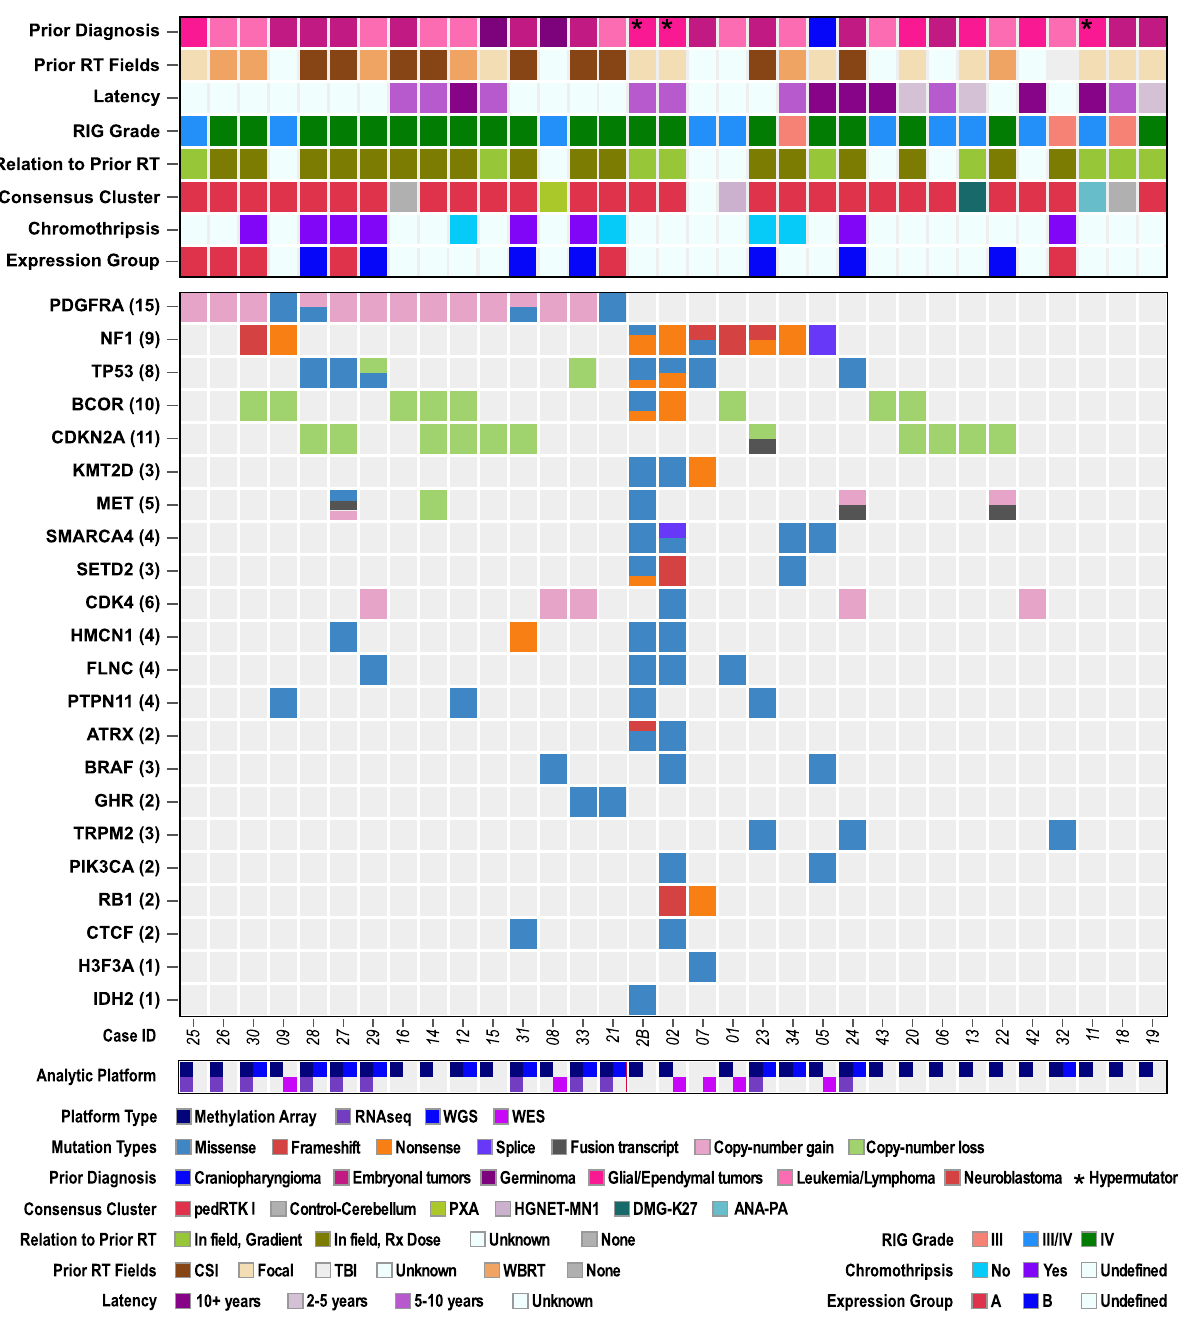
Fig. 4 Recurrent molecular alterations in RIG. Summary by RIG sample of clinical characteristics, histopathological features, methylation pro fi le, tier1 mutations, genes affected by copy-number gain/loss, and fusion genes. The second sample for Case 2 is shown as Case 2B, whereas the second samples for Case 14 and Case 12 are not shown but are annotated in Supplementary Data 1. ANA PA anaplastic pilocytic astrocytoma, CONTR-CEBM control cerebellum, DMG-K27 diffuse midline glioma H3.3 K27M, GBM-MID glioblastoma IDH-wild type, subclass midline, HGNET-MN1 high-grade neuroepithelial tumor with MN1 alteration, PXA pleomorphic xanthoastrocytoma, RIG radiation-induced high-grade glioma. Sequencing/array platforms for each case are also shown in the bottom in DNA-repair pathway gene expression (Fig. 6c). Using DNA- repair genesets available in the MSigDB (Broad Institute), individual genes appearing in multiple genesets were identi fi ed, and their expression correlated with DNA repair (Fig. 6d) 24,26 – 31 . In a pairwise comparison, mean fold change (Group B/Group A) of genes shown in Fig. 6d was 0.76 ( P = 9.79 × 10 − 11 vs. expected value of 1) (Supplementary Table 4).